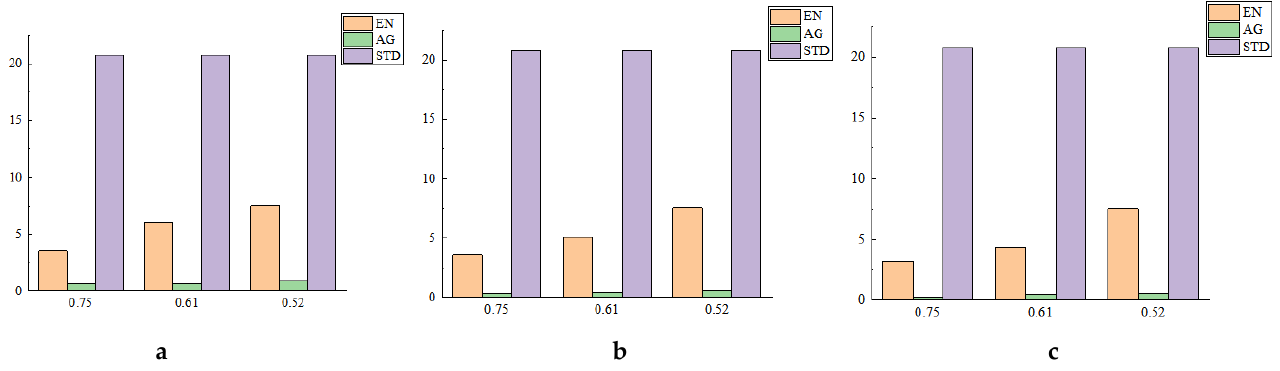
Figure 14. Objective evaluation index of images with different optical thickness of sea fog a . 670 nm b . 530 nm c . 450 nm.